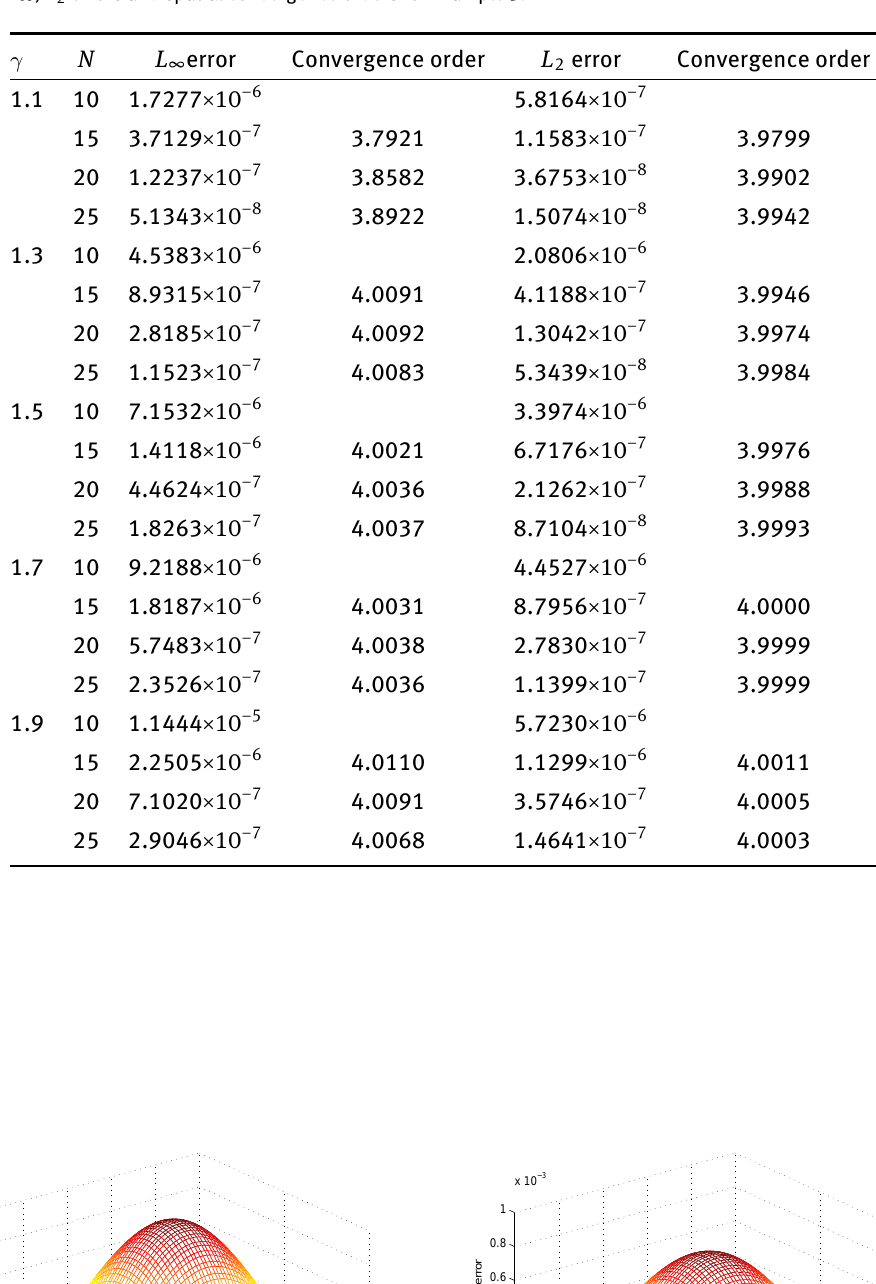
Table 6: The L ∞ , L 2 errors and spatial convergence orders for Example 3.